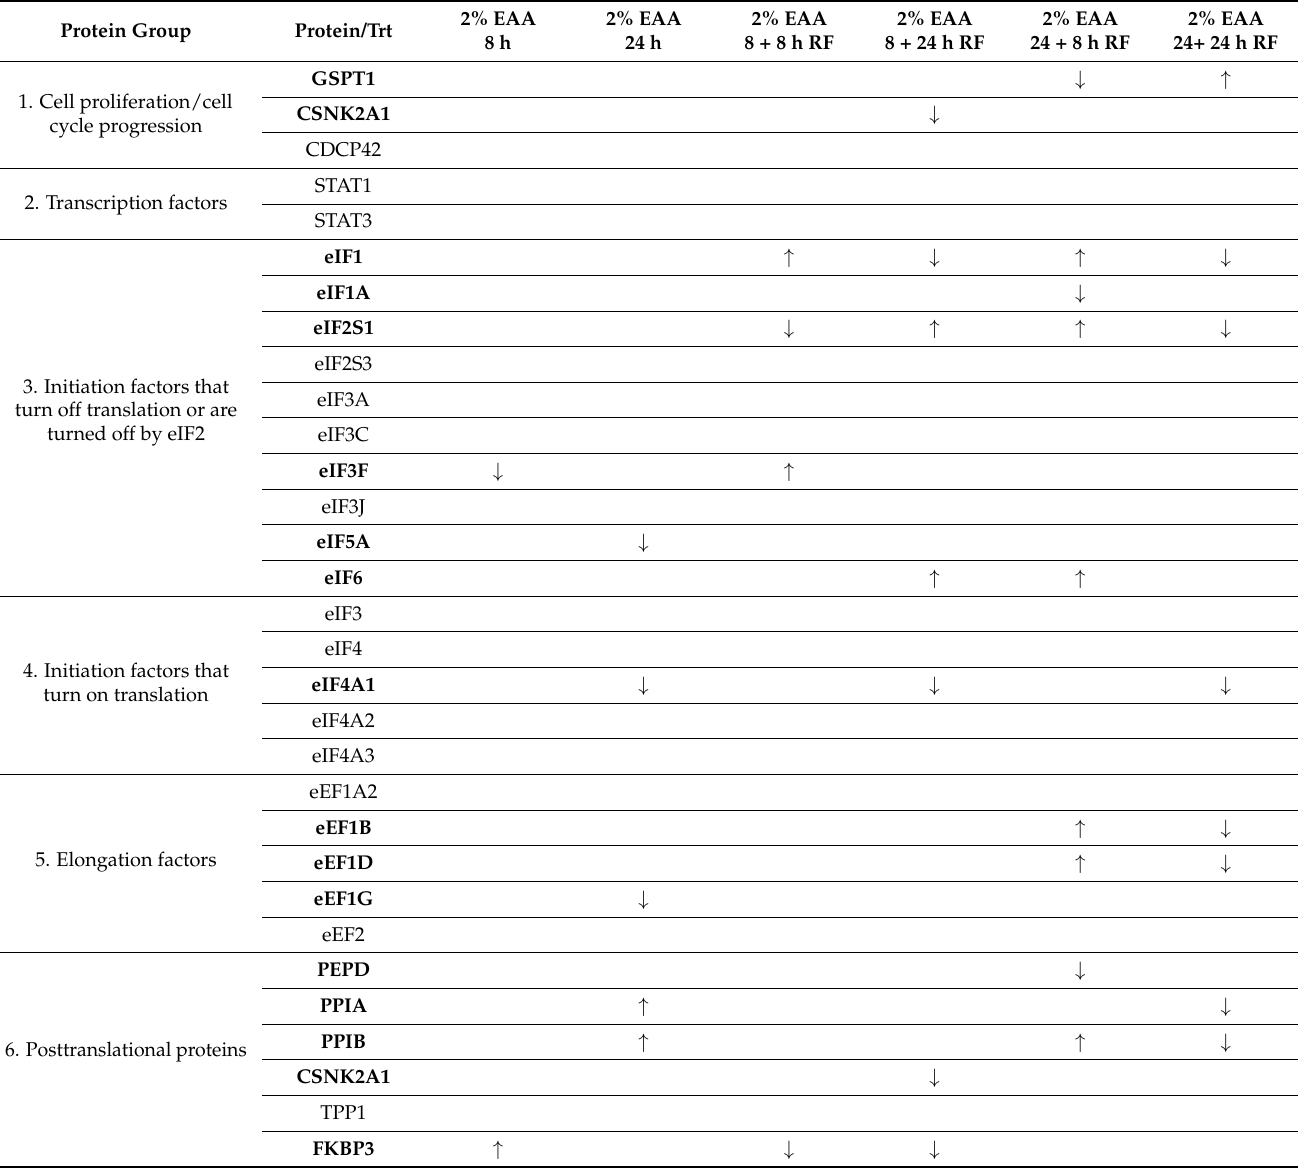
Table 1. Proteins ( n = 30) related to protein synthesis in the MEC model and effects of different treatments (Trt.: depletion with 8 and 24 h with 2% EAA; repletion with 100% EAA for 8 and 24 h after 8 and 24 h of depletion) on protein expression. Significant differences in protein expression ( p < 0.05) are shown in bold ( n = 16). Arrows (up or down) indicate the effect of treatment on protein concentration compared with the control (100% EAAs). MEC: mammary epithelial cell; EAA: essential amino acid; Trt: treatment; GSPT1: G1 to S phase transition 1; CSNK2A1: casein kinase 2 alpha 1; CDCP42: cell division control protein 42; STAT: signal transducer and activator of transcription; eIF: eukaryotic initiation factor; eEF: eukaryotic elongation factor; PEPD: peptidase D; PPI: peptidylprolyl isomerase; TPP1: tripeptidyl-peptidase 1; FKBP3: FKBP prolyl isomerase